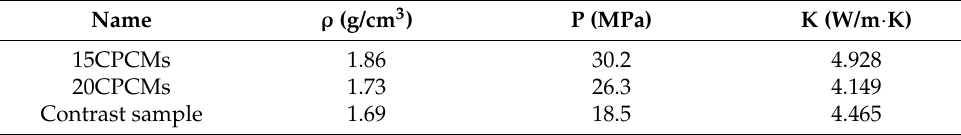
Table 1. Density, mechanical strength and thermal conductivity of the composite